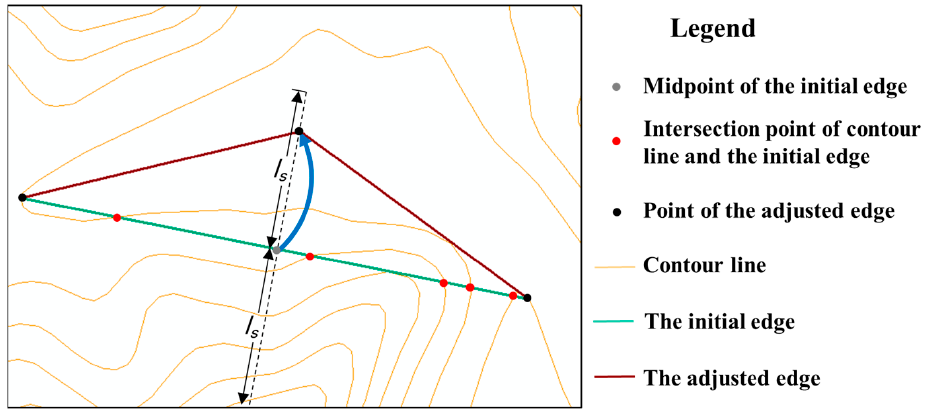
Figure 6. Gradually descending valley edge corrections. The maximum moveable length of the midpoint of the gradually descending valley edge is l S .